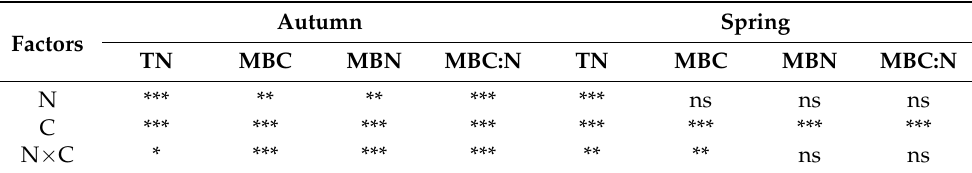
Table 5. The output of a two-way ANOVA for the yield of tomatoes, total N uptake (TN) of tomato plants, microbial biomass carbon and nitrogen (MBC and MBN), and microbial biomass C:N (MBC:N) as affected by biochar (C0, C10, C30, C50, C70, and C90) and N fertiliser rates (N1 and N2). The data are presented in Figure 2 and Figure 5. Autumn Spring Factors TN MBC MBN MBC:N TN MBC MBN MBC:N N *** ns